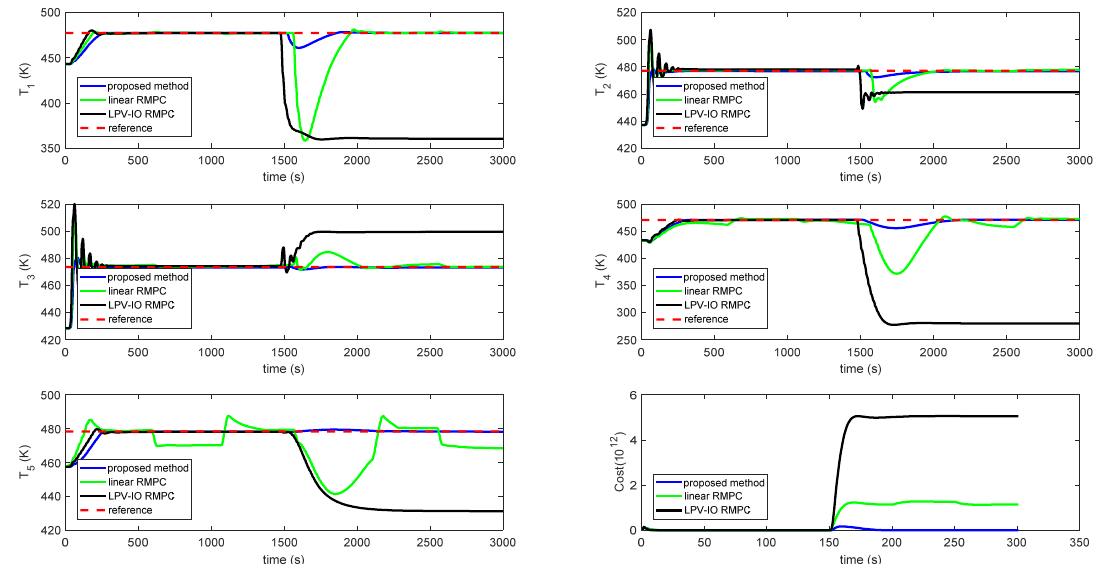
Figure 6. The temperatures of vessels and cost function using three studied methods (dashed red line: references, the blue line: proposed method, the green line: linear RMPC, the black line: LPV-IO RMPC).